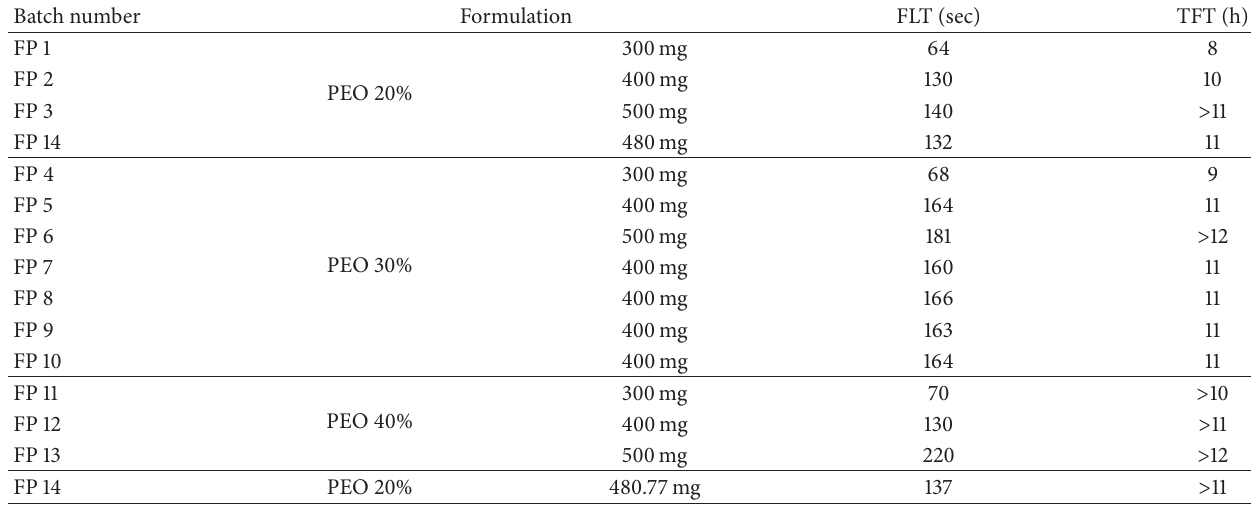
Table 3: Floating lag time and total floating time of floating pulsatile release